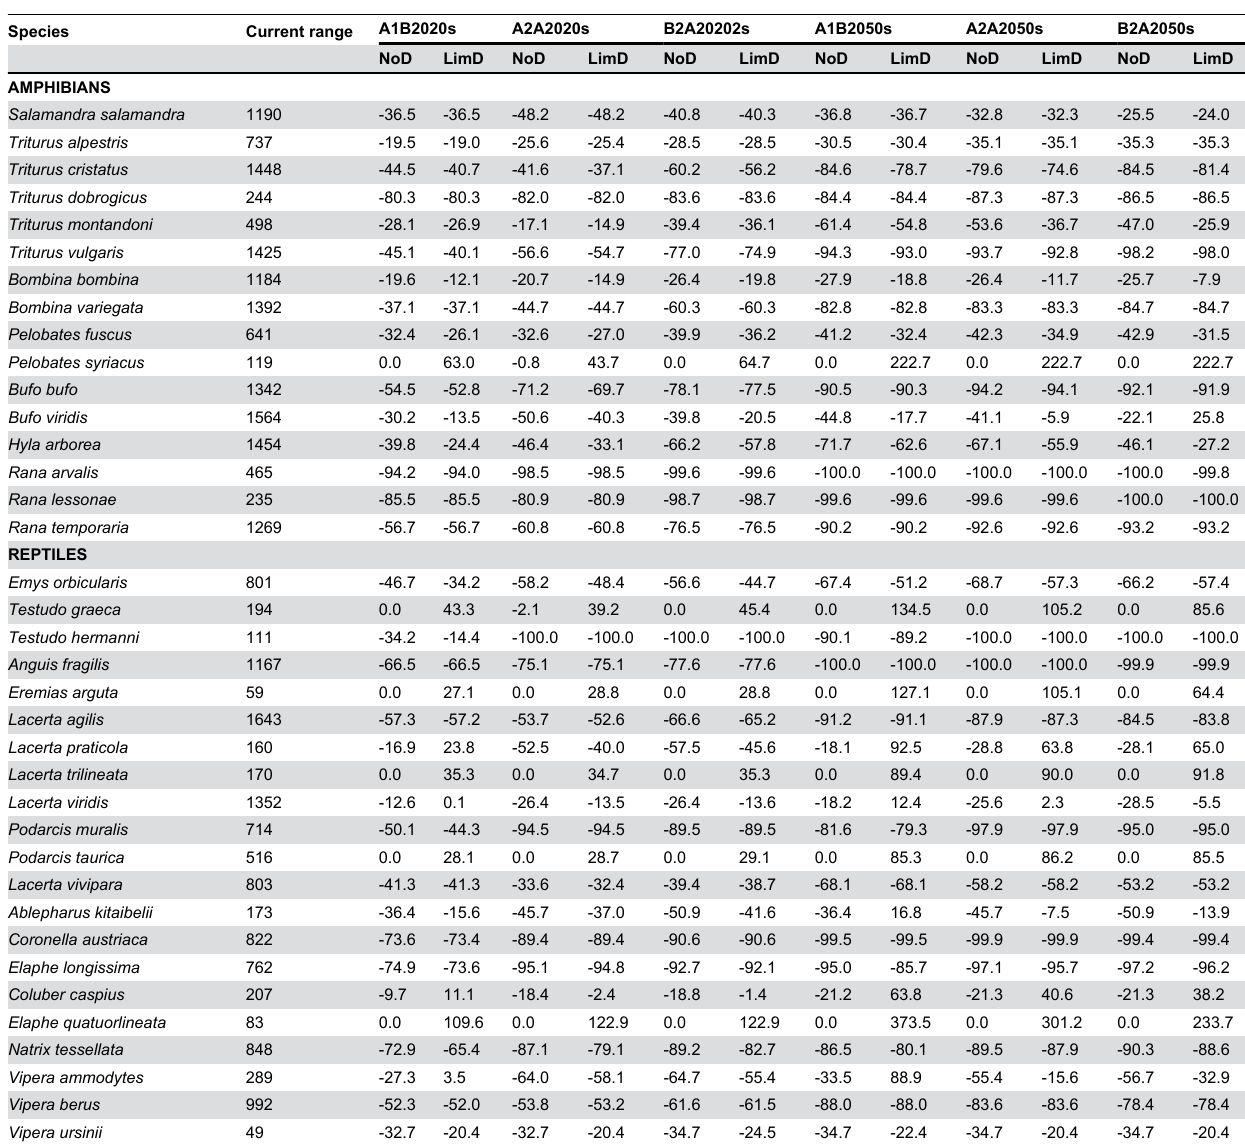
Table 1. Current range extent (number of occupied 10 × 10 km grid cells) and percent range change under future climate conditions (2020s and 2050s time horizons, emission scenarios A1B, A2A, and B2A) and dispersal assumptions, predicted using ensemble species distribution models; negative values denote range contractions (LimD = limited dispersal; NoD = no